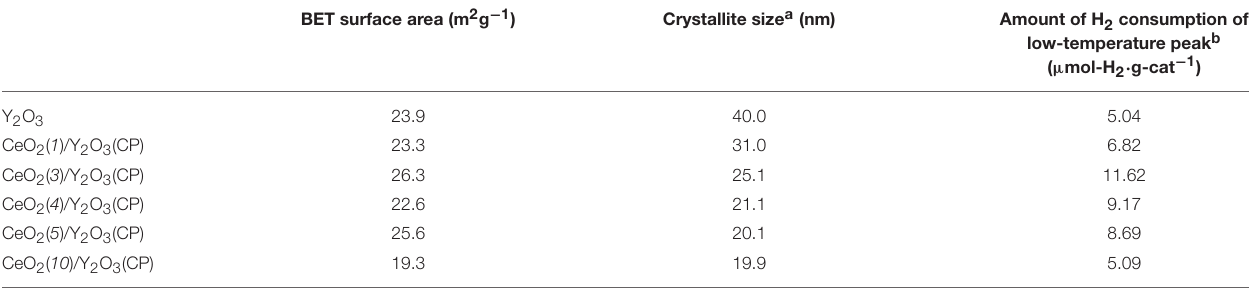
TABLE 2 | BET surface area, crystallite size of Y 2 O 3 and the amount of H 2 consumption in H 2 -TPR of CeO 2 ( x )/Y 2 O 3